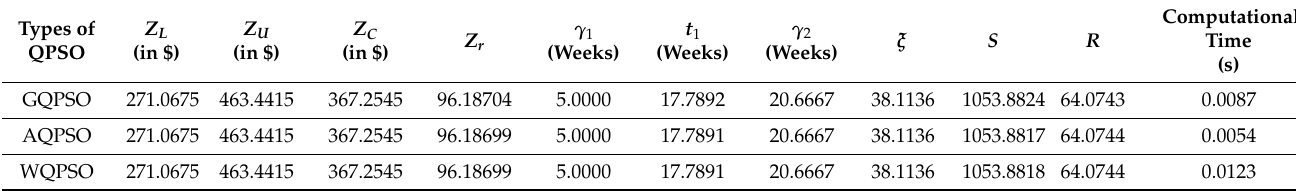
Table 5. Best found solutions for Case-II of Example 2.